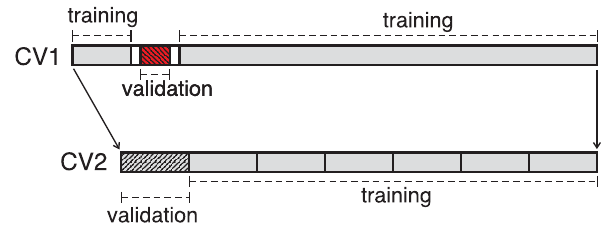
Fig. A1. Schematic diagram illustrating the double cross-validation procedure. In the outer round (CV1), the training data are shown in grey and the 3-year validation data shaded. The 1-year data seg- ments (shown in white) bridging the training data and the validation data are not used, to avoid autocorrelation leaking information from the training data to the adjacent validation data. The validation data segment is moved repeatedly in 3-year increments from the start of the data record to the end in this cross-validation loop, so forecast performance is validated over the whole record. Meanwhile in the inner loop (CV2), the training data from CV1 are assembled and divided into 7 segments, with 6 used for training and one (shaded) for validation. Again the training and validation segments are ro- tated in the loop so all segments are eventually used for validation to determine the optimal model values/hyperparameters. The opti- mal model determined from CV2 is then used to forecast over the 3-year validation segment in